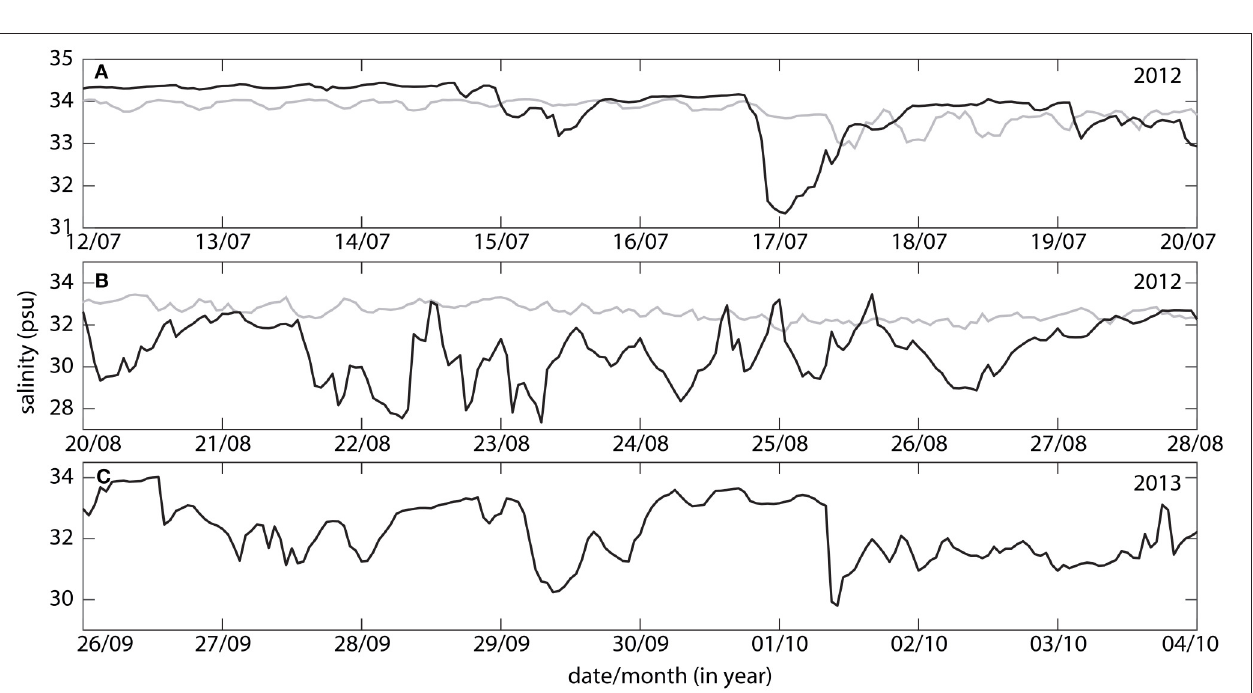
FIGURE 4 | Power spectral density from (A) WilsonB and (B) Waiheke from 1 m above bed (gray line) and near surface ADCP bins (black line).